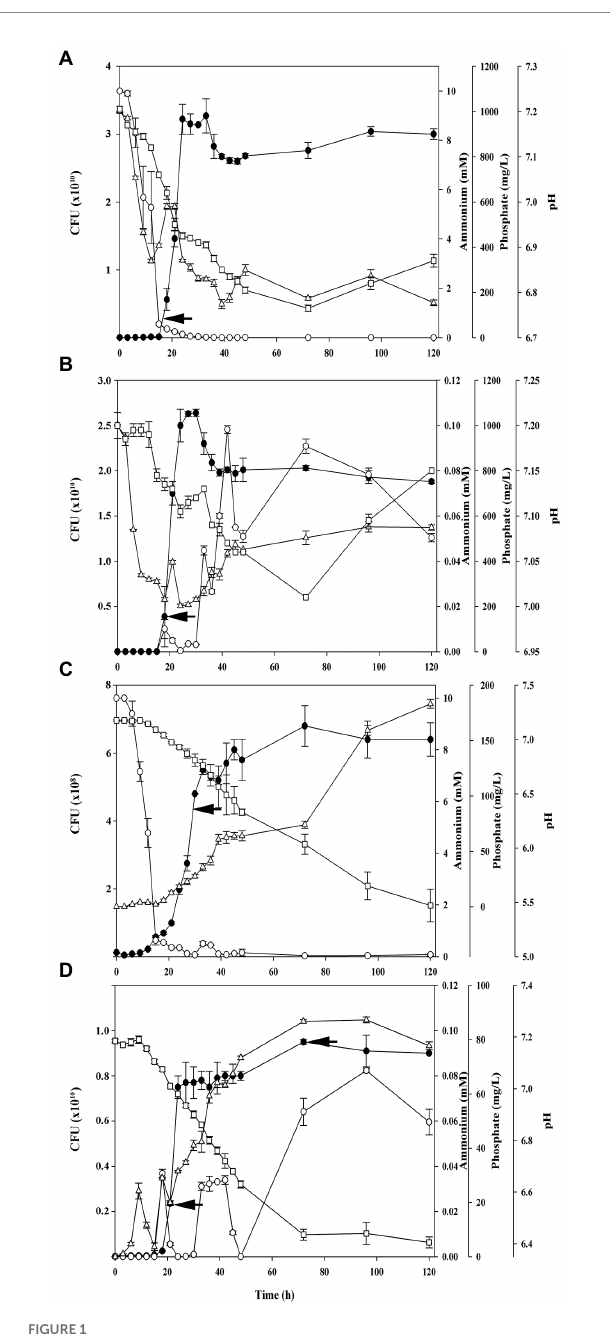
FIGURE 1 Growth curves and extracellular ammonium (mM), phosphorus (mg/L) and pH of Azotobacter chroococcum NCIMB 8003 cultures in the different conditions used: (A) Control, with 10 mM ammonium chloride and soluble phosphorus, (B) Diazotrophic condition (BNF), with soluble phosphorus and without ammonium chloride, (C) Phosphorus mobilization condition (PM), with 10 mM ammonium chloride and with tricalcium phosphate as sole phosphorus source, and (D) , Diazotrophic and phosphorus mobilization condition (FP), without ammonium chloride and with tricalcium phosphate. For each condition, bacterial growth is shown as CFU counting (black circles), extracellular ammonium (circles), extracellular soluble phosphorus (triangles) and extracellular pH (squares). Cells were precultured in nitrogen-free minimal medium with 110 mM glucose as carbon source for 24 h. Then, cells were harvested by centrifugation, washed in 0.85% NaCl and inoculated to an initial optical density at A600 of 0.05. The arrows show the collection times of the different conditions for further